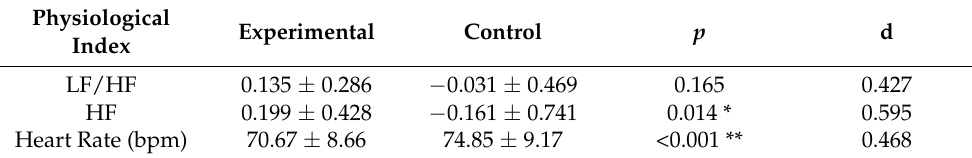
Table 4. Comparison of physiological indices (control and experimental values). Physiological